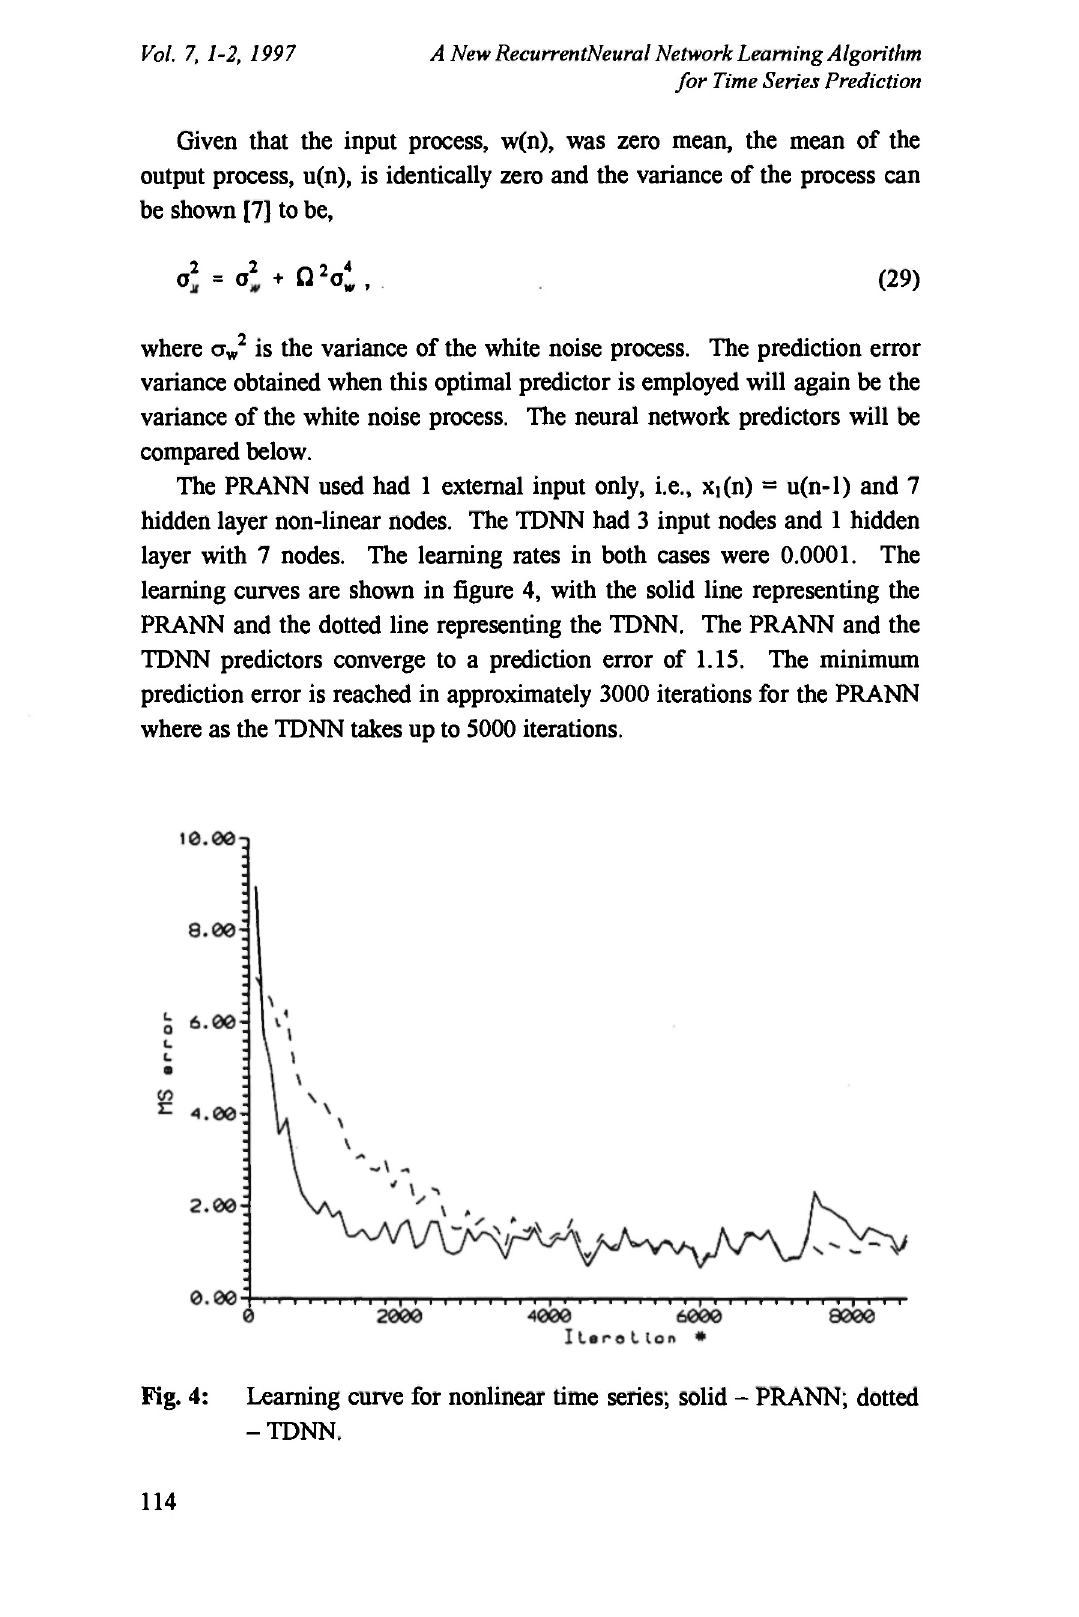
Fig. 4: Learning curve for nonlinear time series; solid - PRANN; dotted